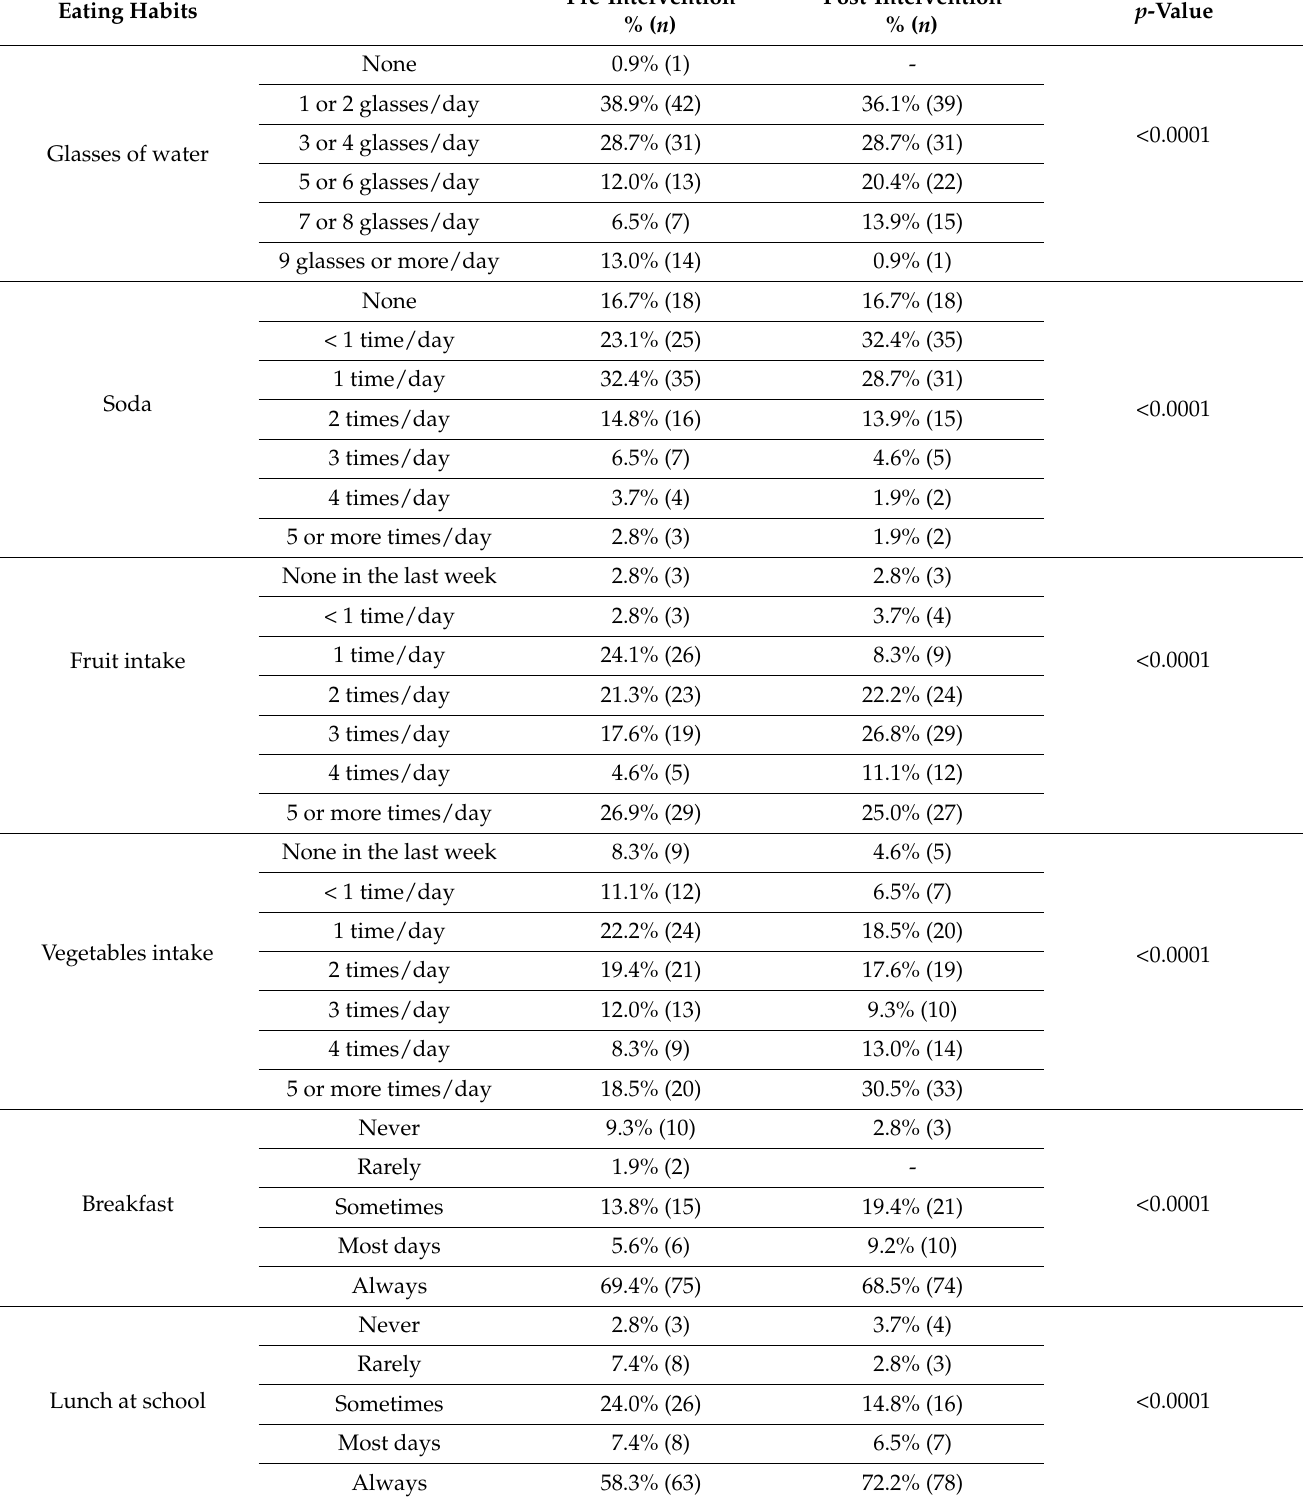
Table 3. Comparison of students’ eating habits before and after the educational